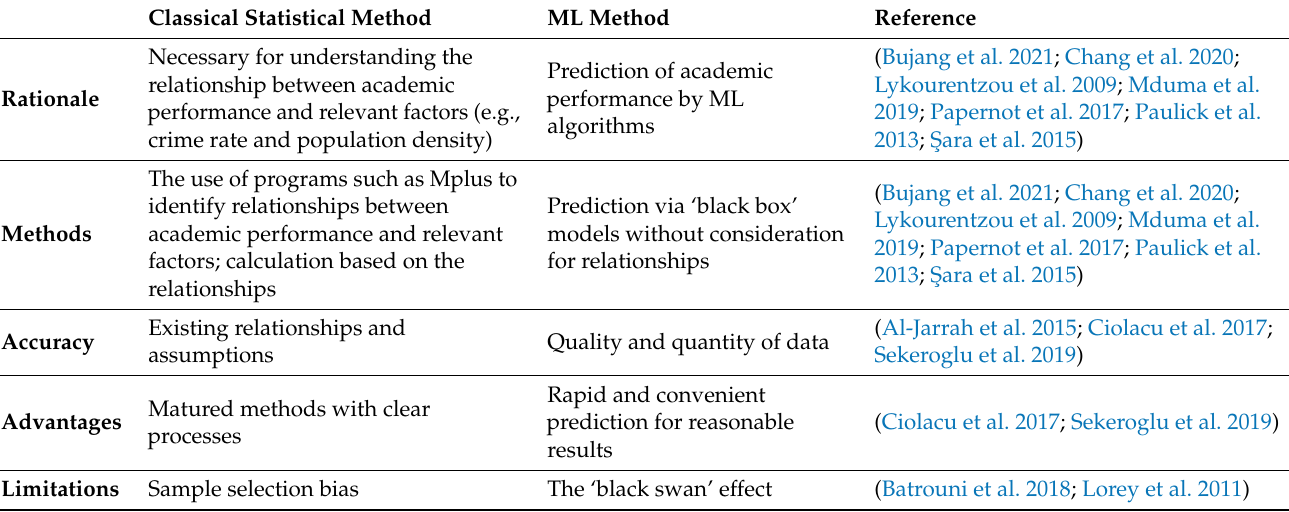
Table 1. Comparison of a classical statistical method (e.g., correlation and linear regression) and